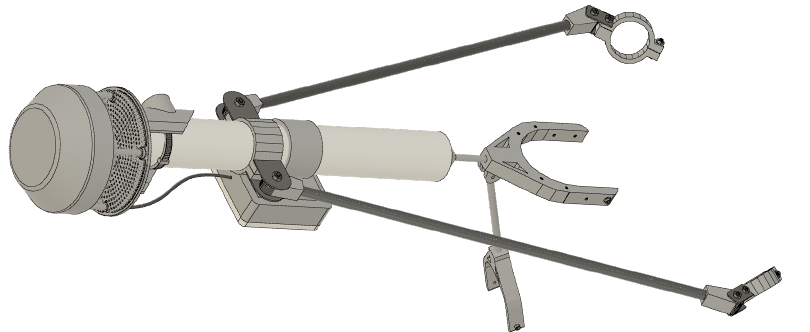
Figure 2. Schematic of Inspire 2 sampler assembly. An interactive 3D version can be found at